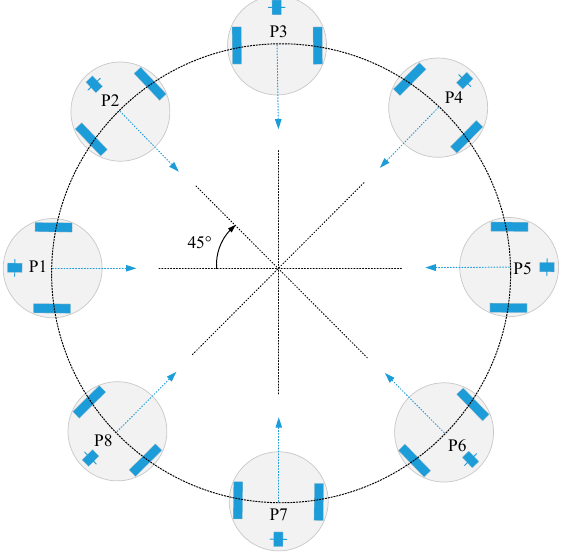
Figure 13. The configuration diagram of eight robots for the benchmark comparison.